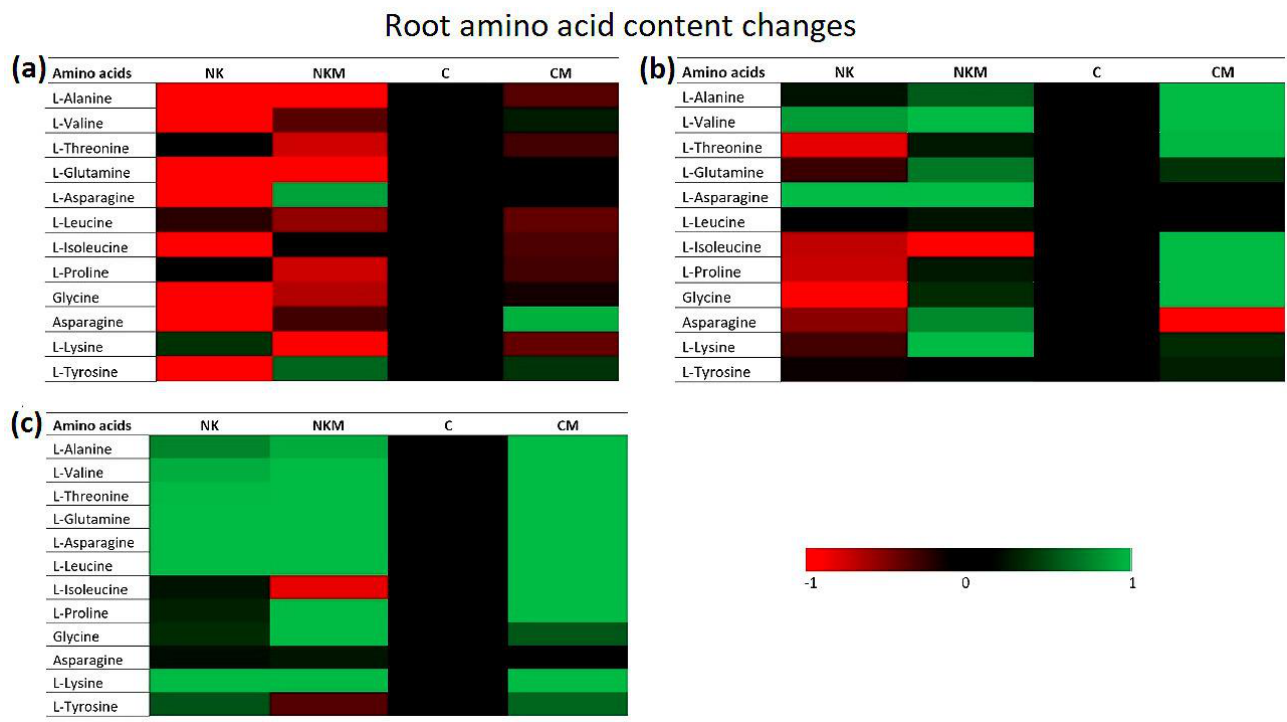
Figure 9. Heatmap of root amino acid content changes in all treatments (NK: KNO 3 fertilizer; NKM: KNO 3 in combination with PGPR; CM: NH 4 NO 3 fertilizer in combination with PGPR) in comparison with the control (C: NH 4 NO 3 fertilizer) in the first ( a ), second ( b ) and third ( c ) sampling periods. The green color indicates increased levels of metabolites, while the red color indicates decreased levels of metabolites. Amounts have been expressed as relative abundance based on the relative response compared to the internal standard (adonitol).